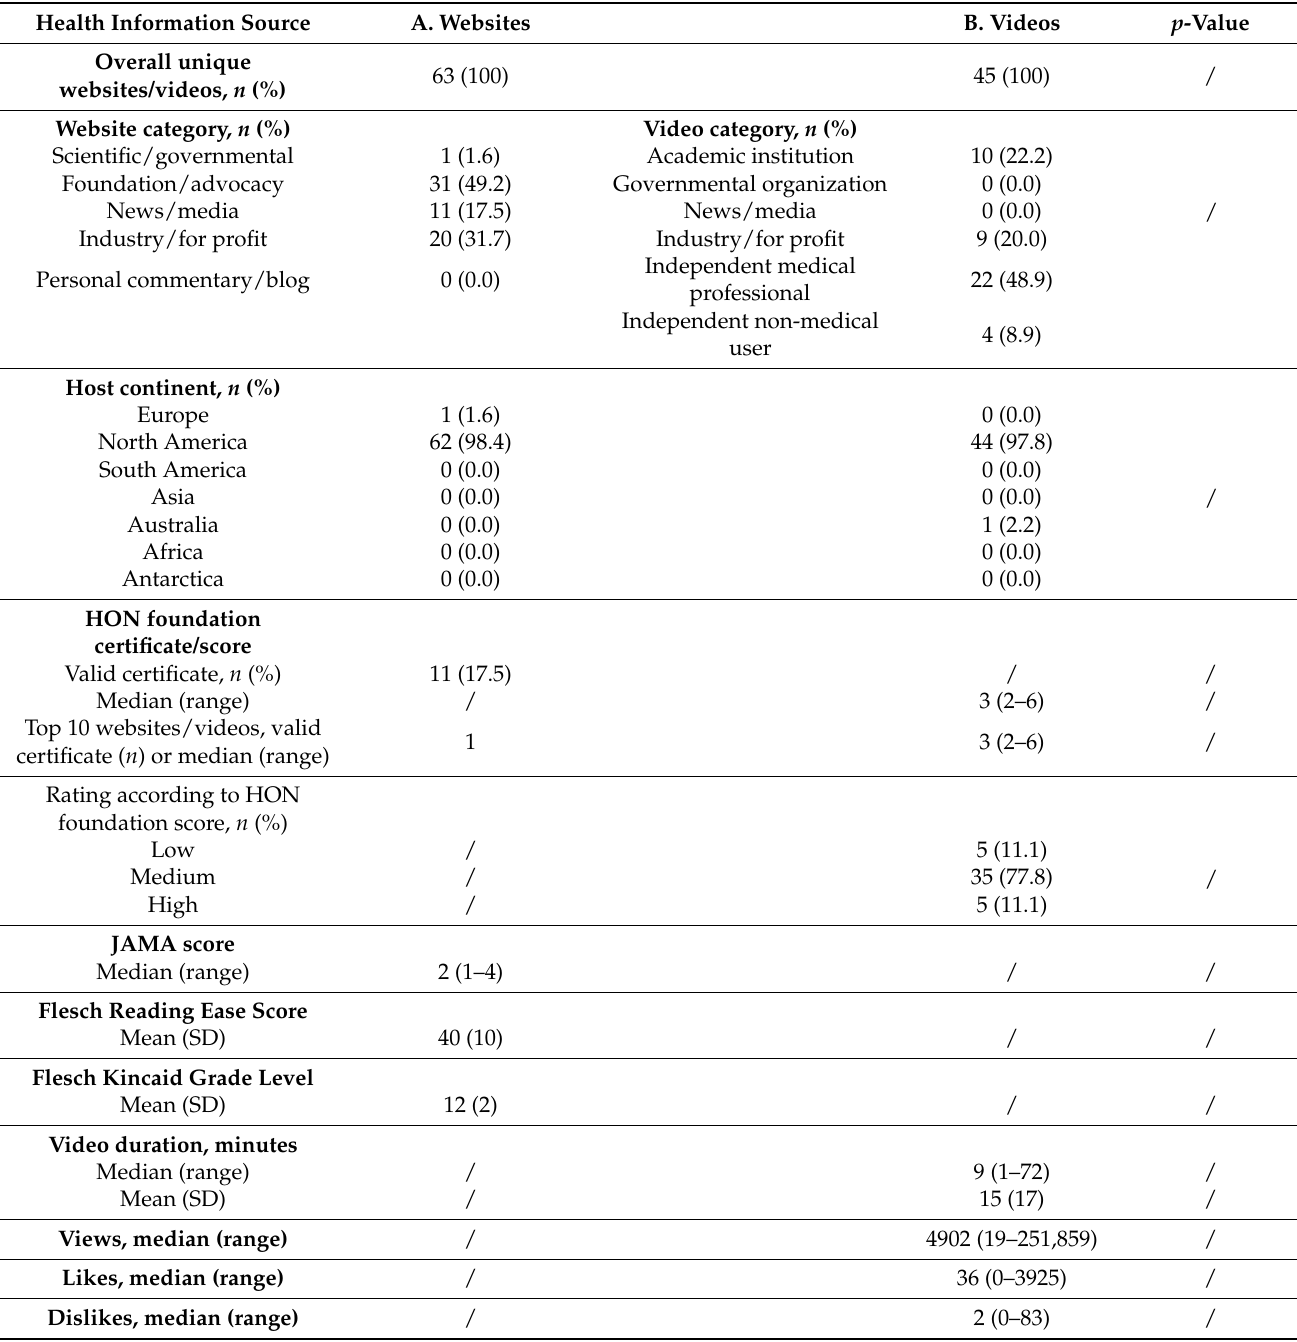
Table 1. Characterization of unique websites and